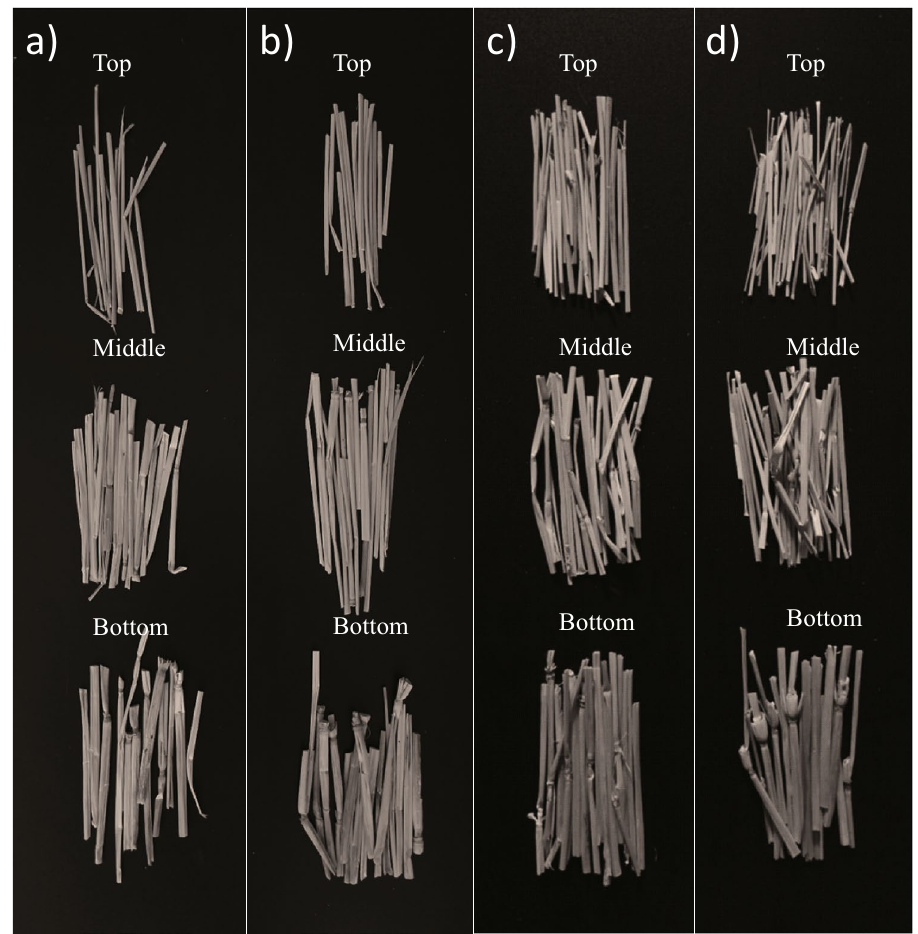
Figure 1. Pictures of the culm of ( a ) R1, ( b ) R2, ( c ) R3, and ( d ) R4. The culm was cut into 3 parts: top, middle, and bottom (or